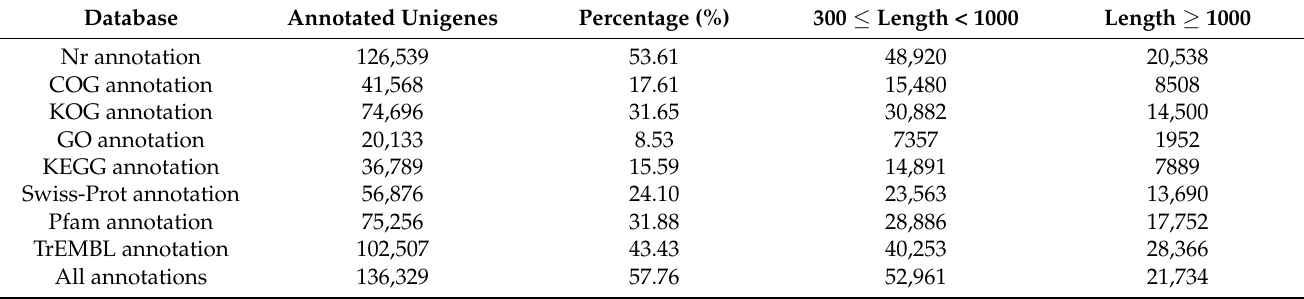
Table 2. Functional annotation statistics of R.officinale unigenes against eight publicly avail- able